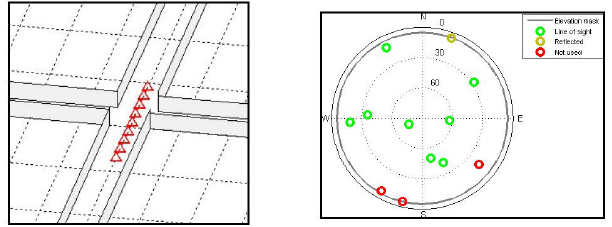
Figure 3: Vehicle track (left) and skyplot with satellite visibility